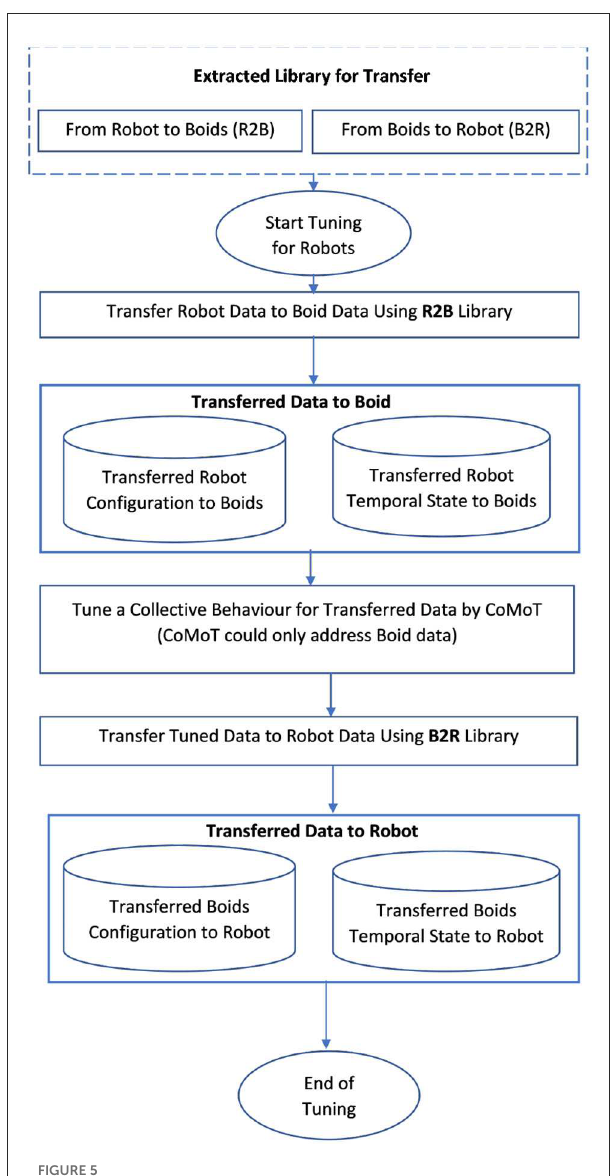
FIGURE5 Transfer learning for collective motion tuning in robots.